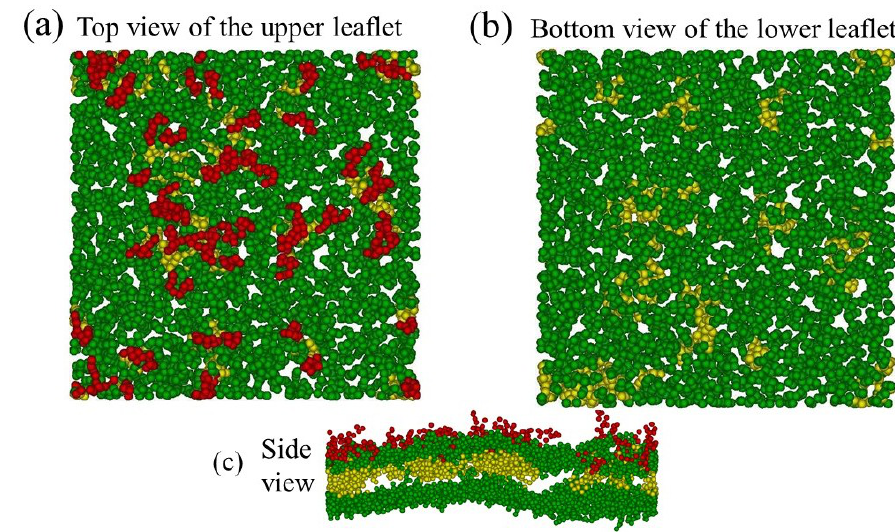
Figure 2. Representative snapshots of the equilibrium asymmetric membrane. ( a ) Top view of the upper leaflet. ( b ) Bottom view of the lower leaflet. ( c ) Side view of the membrane. Note that only loop-shape copolymers are shown and all bridge-shape copolymers and lipid tails are omitted. Green, red, and yellow beads represent lipid head, hydrophilic and hydrophobic beads of the copolymer, respectively.